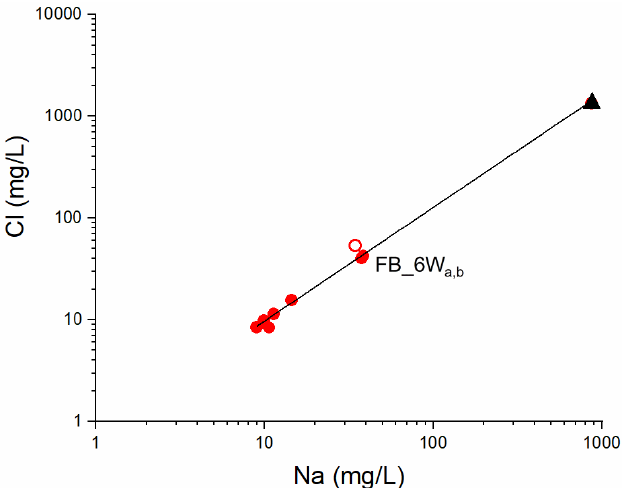
Figure 6. Na (mg/L) vs. Cl (mg/L) diagram with the linear fitting (black line). Red filled circles: groundwater from FB_1W to FB_6W; red open circle: modelled FB_6W water (see text); black filled triangle: deep water (see text).